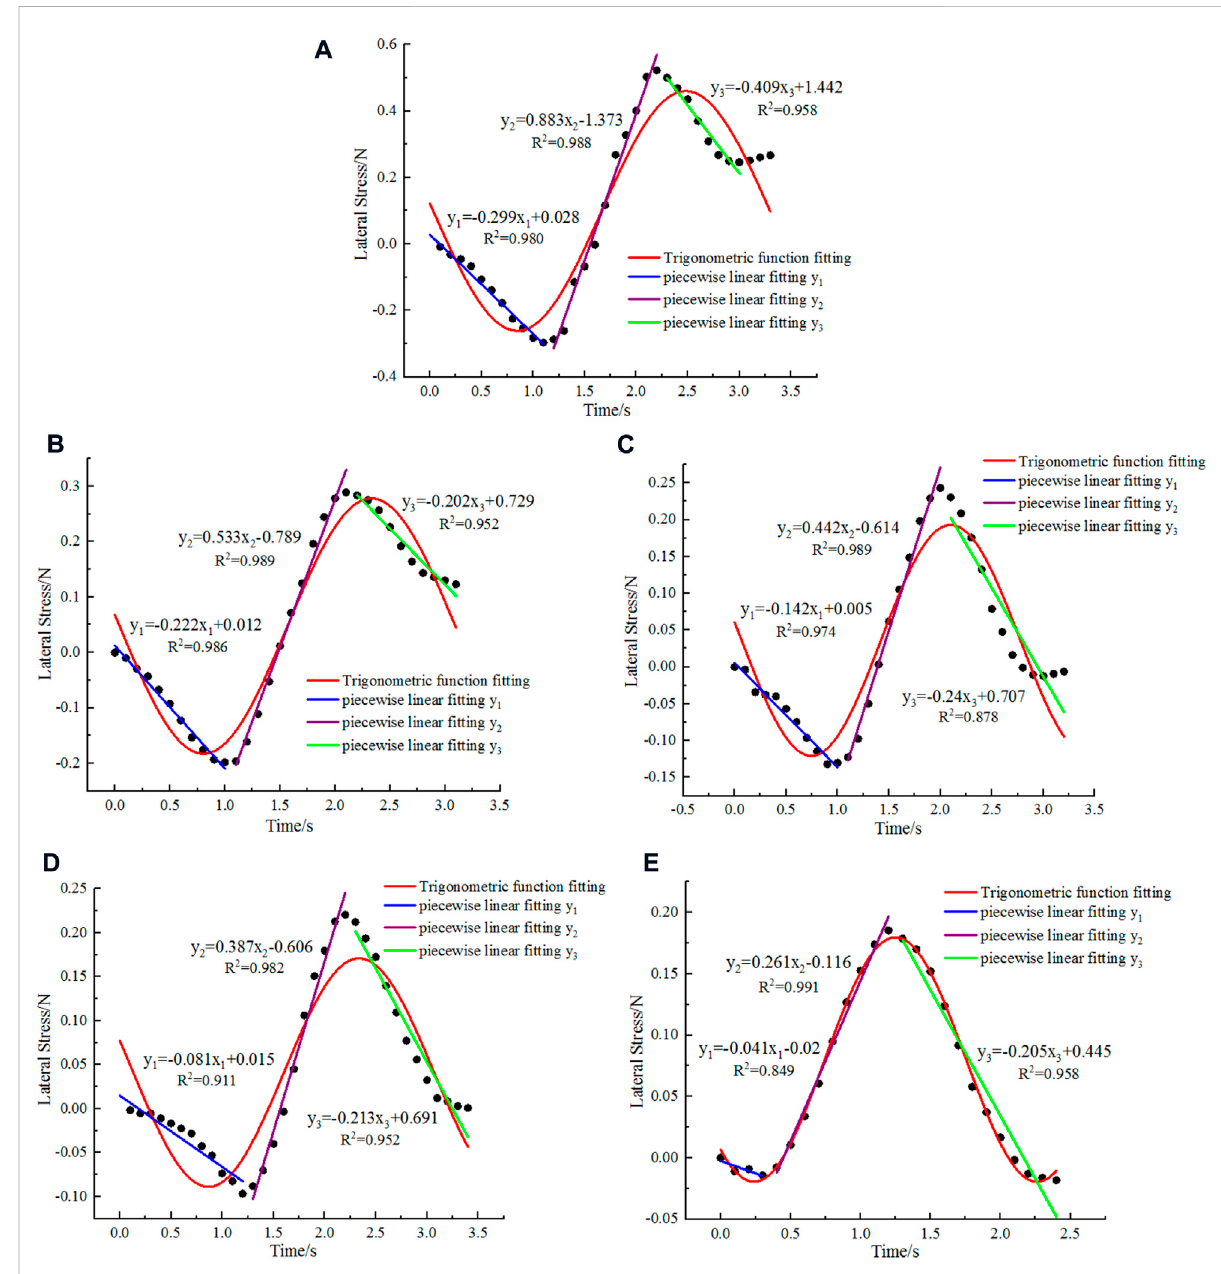
the third segment (decreasing lateral stresses) were -0.409, -0.202, -0.240, -0.213, and -0.205, respectively, with an average value of -0.2538. Based on the average slopes of the fi tting curves for the three segments, the average variation rate of the fi rst segment (decreasing trend) was the smallest, whereas the second segment (increasing trend) was the largest. This differs from the shallow-soil